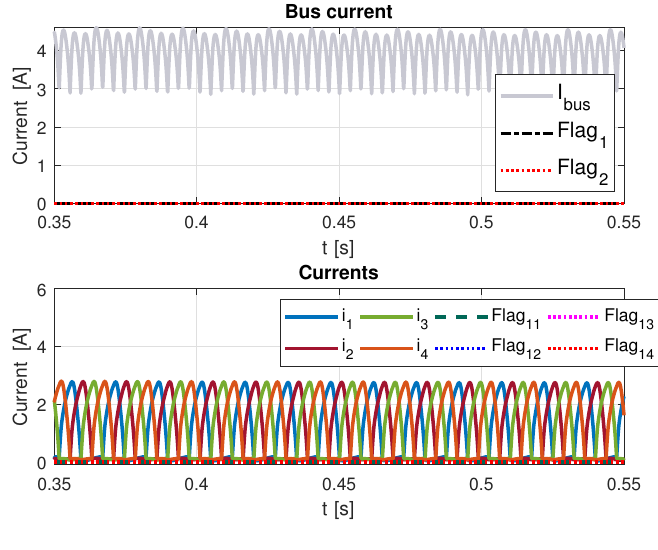
Figure 7. Normal